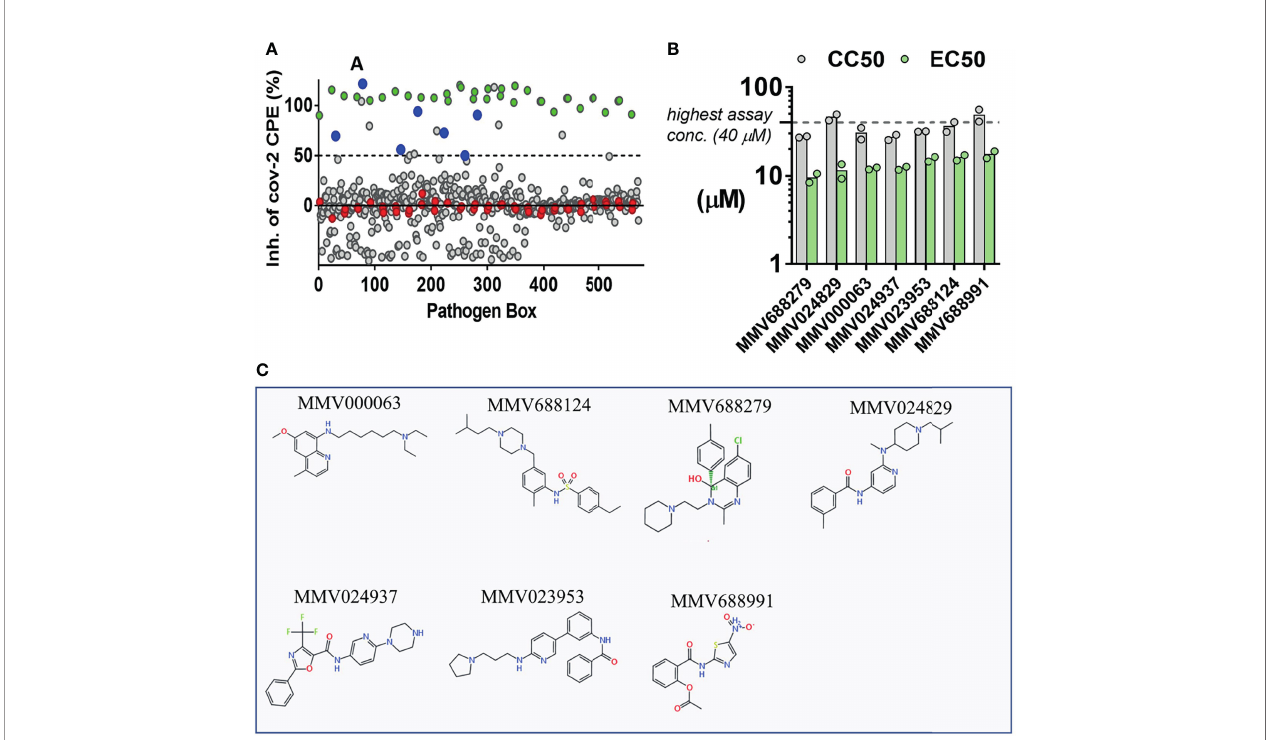
FIGURE 2 | Screening of the MMV Pathogen Box for inhibitors of SARS-CoV-2-induced cytopathic effect (CPE) in Vero CCL81 cells. (A) 400 compounds (grey circles) were tested for the ability to inhibit virus-induced CPE and cell death. Non-infected wells (100%, green) and infected vehicle-treated (0%, red) were used as controls. Seven compounds (blue circles) that inhibited CPE > 50% were classi fi ed as hit candidates. (B) EC 50 /CC 50 values for 7 hit compounds. Bars represent means of two independent experiments performed on different days. Dots represent mean values from independent concentration-response curves performed in triplicate. (C) Chemical structures of 7 selected